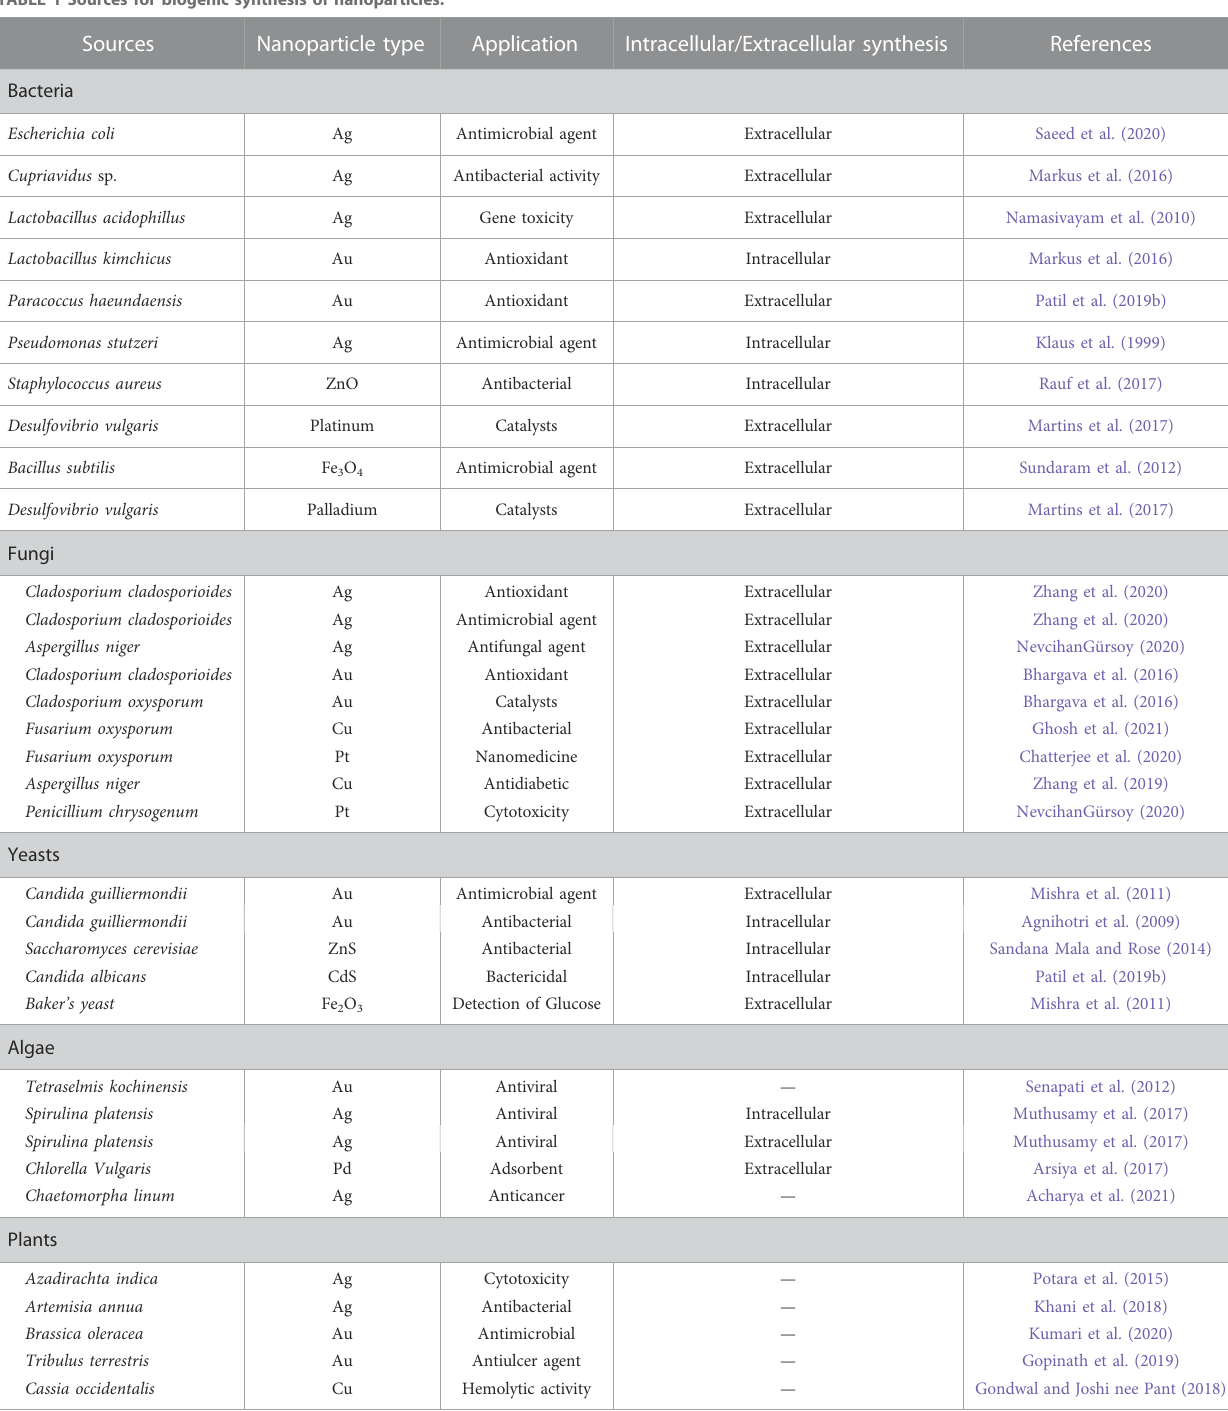
TABLE 1 Sources for biogenic synthesis of